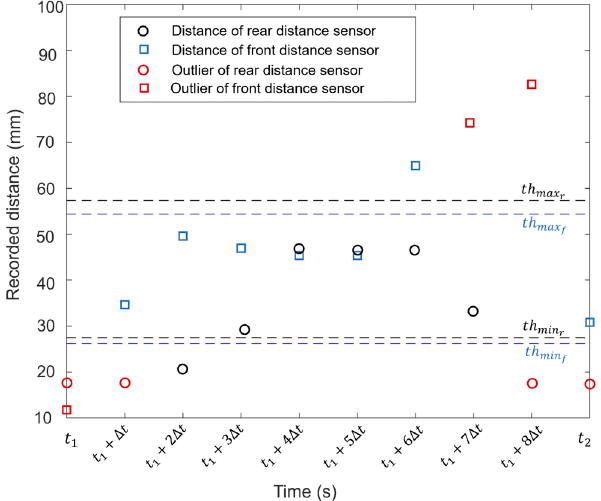
Figure A1. Example of recorded distance data from rear (dots) and front (squares) distance sensors during a swing of the instrumented foot during a walking trial at fast speed (1.8 m/s). Red data correspond to the outliers exceeding the 95% confidence intervals. The dashed horizontal lines determine the thresholds within which the distance data from rear (black) and front (blue) distance sensors are considered reliable.